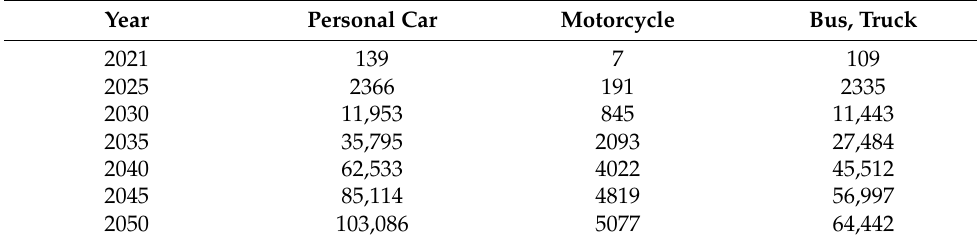
Table A1. Total EV load forecast (GWh).